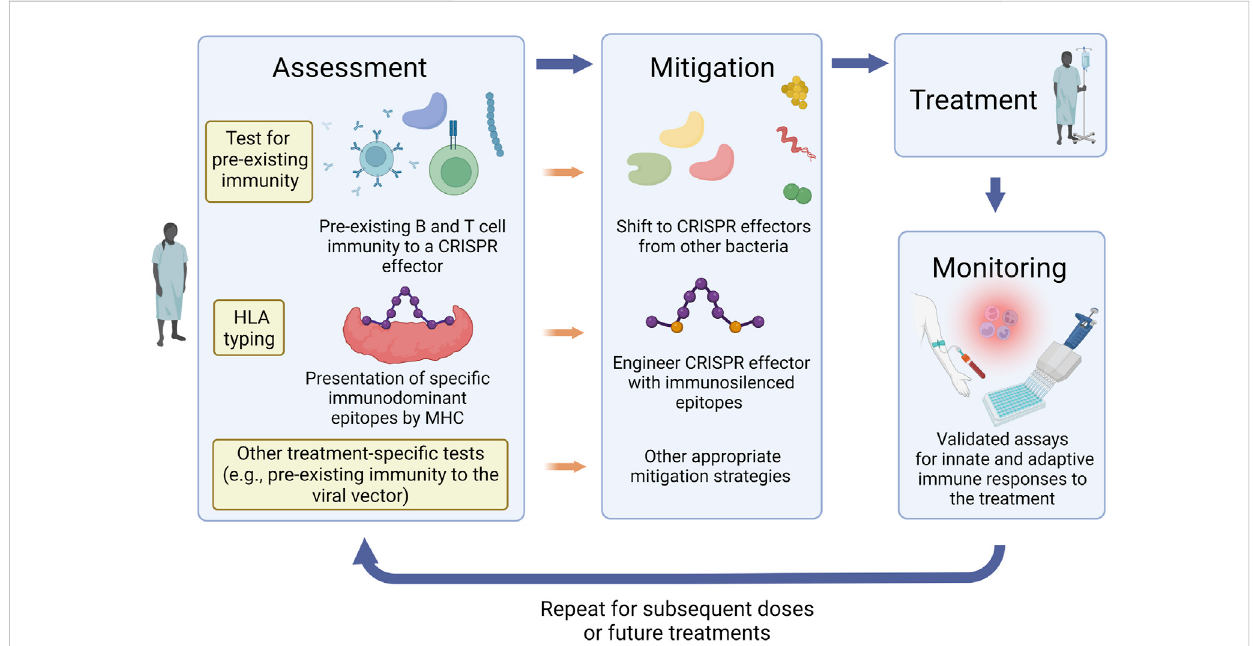
FIGURE 2 Assessment, mitigation, and monitoring of immune responses to CRISPR therapeutics. Strategies for mitigation of immune responses can be personalizedtoeachpatient ’ sneeds,history,immunestatus,andtreatmentplan.Pre-treatmentassessmentprotocolscanincludescreeningforimmune responses to different CRISPR effector proteins, HLA typing, and other tests that are relevant to the treatment approach such as pre-existing immune responses to the viral vector if one is used for delivery. According to the assessment results, appropriate mitigation strategies can then be implemented. These can include selection of a CRISPR effector ortholog which the patient has no pre-existing immunity against and engineering the selected protein to silence the immunodominant epitope(s) based on the individual ’ s MHC haplotype. Following administration of the